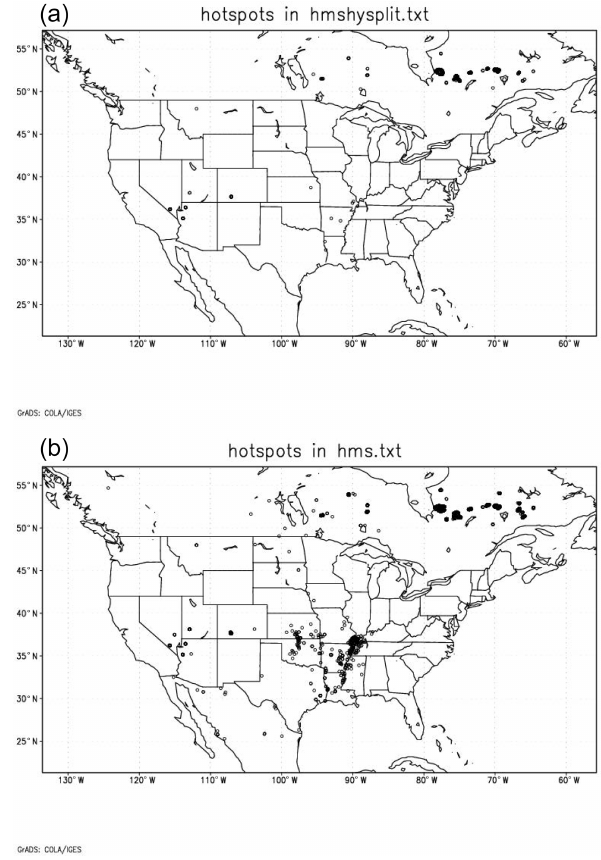
Figure 10. A backward-trajectory analysis for CH 3 CN concentra- tion greater than 400ppt measured along a SENEX flight on 3 July in (a) aerial and (b) time–vertical cross sections.